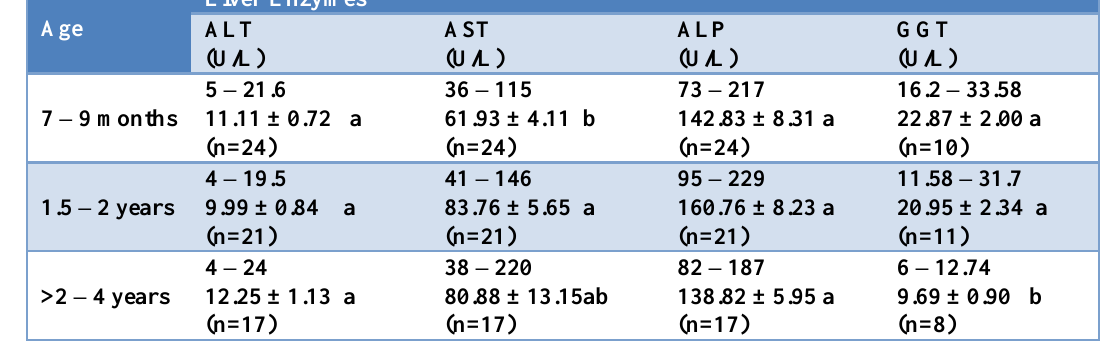
Table 3: The effect of age on serum liver enzymes activities in male Awassi sheep (M± SE) Liver Enzymes Age